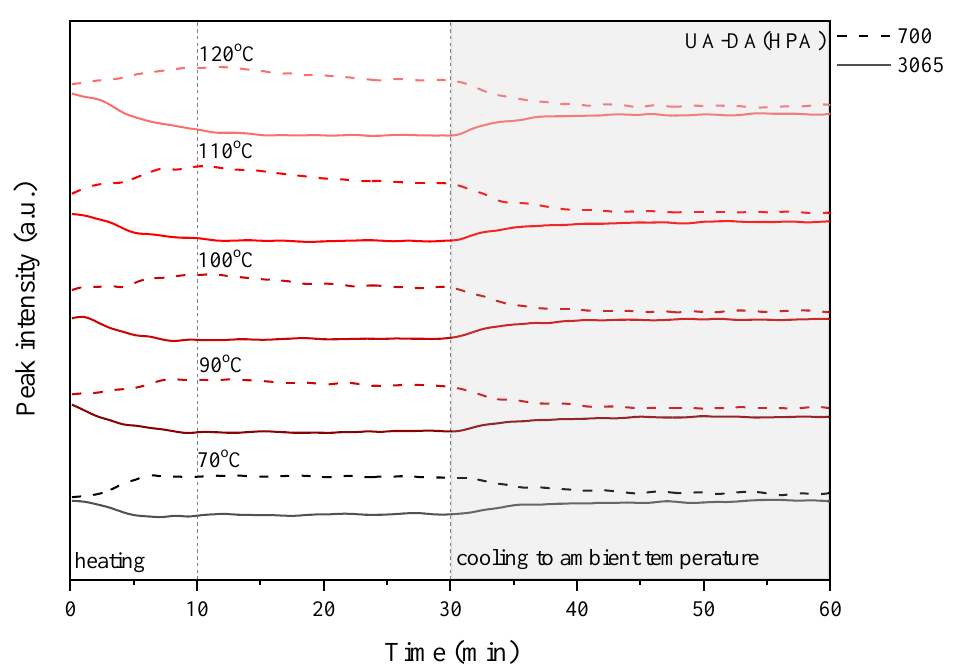
Figure 10. Change in the relative height of selected peaks based on the three-dimensional FTIR spec- trum observed during the heating – thermostat – cooling cycle for the UV-cured UA-DA(HEA) sam- ple.